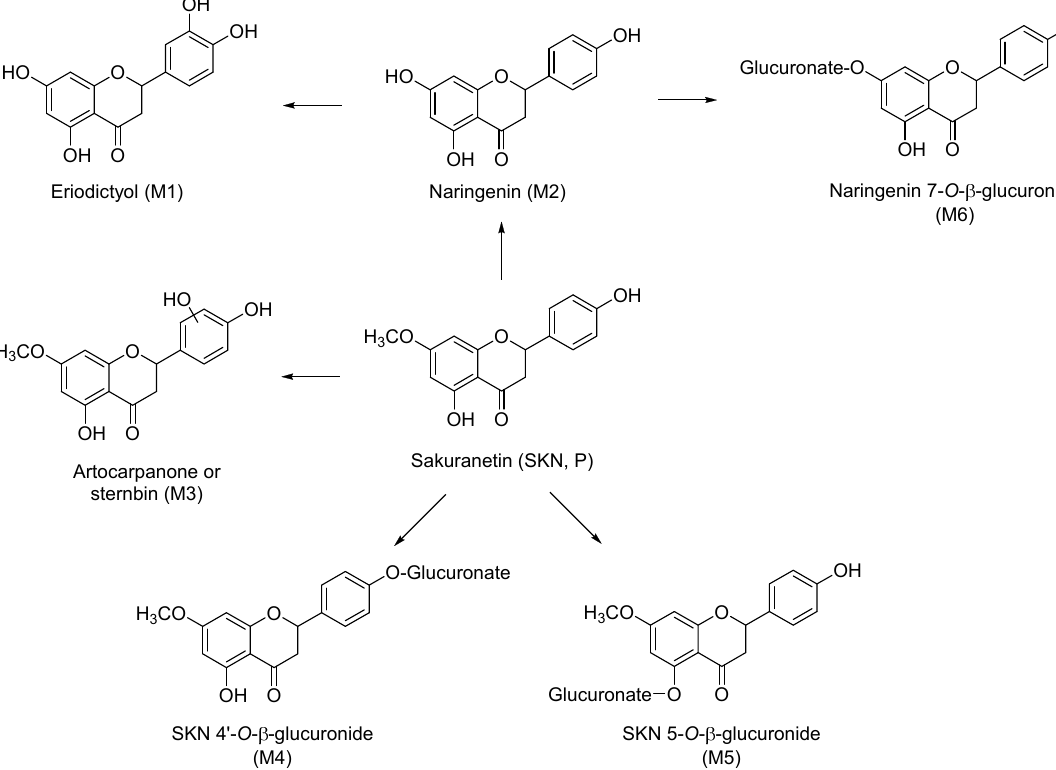
a Numbers represent % inhibition when metabolite formation in a CYP-mediated reaction without inhibitor was set as 100%. Table 5. UDP-glucuronosyltransferase (UGT) inhibition effects of SKN in human liver microsomes. UGT Isozyme